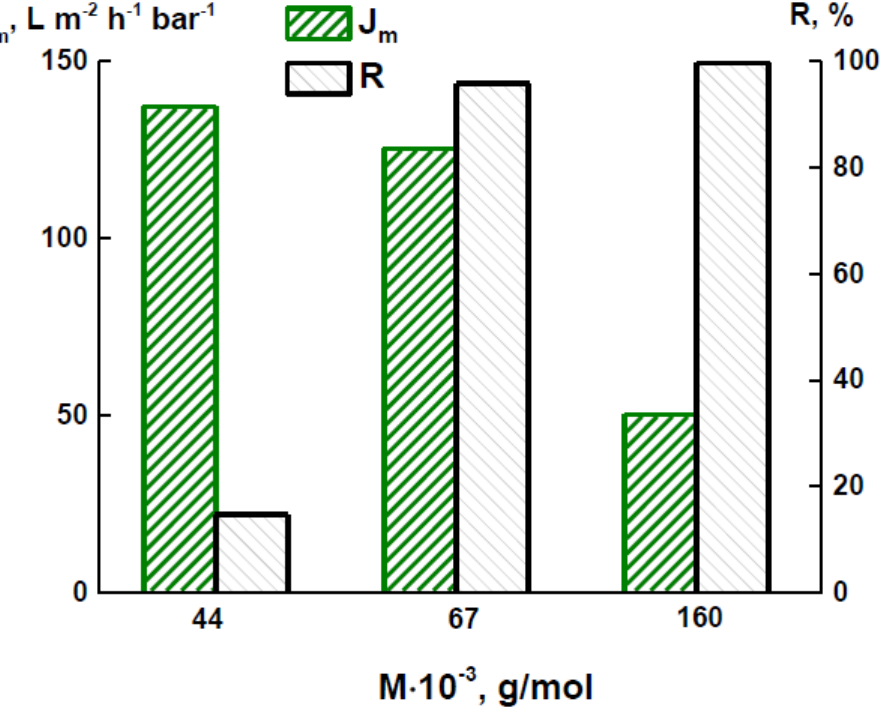
Figure 3. Dependences of the flux of aqueous protein solutions ( J m ) and rejection of proteins ( R ) on their molecular weights for the PAI membrane.